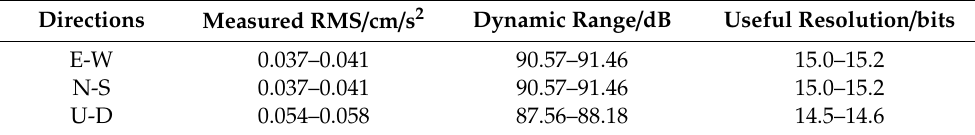
Table 4. Estimated dynamic range and useful resolution of the MNSMSs.